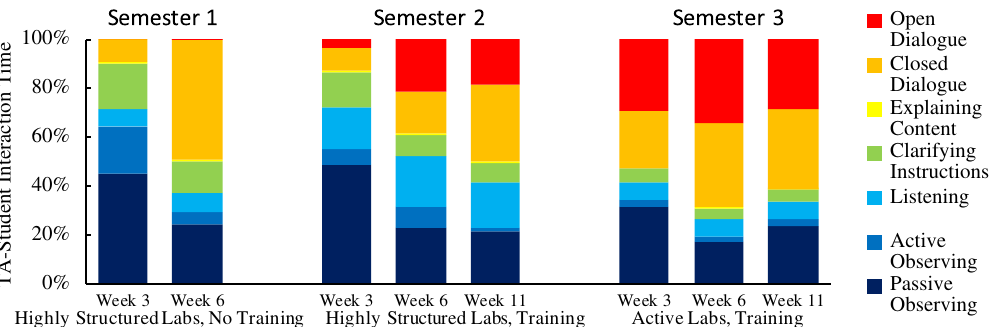
FIG. 4. Comparison of TA-student interactions across three semesters, averaged over all observed TAs. A different set of TAs was observed each semester, and all TAs observed were working their first semester as a lab TA. In the first semester, a highly structured lab curriculum was used with no lab TA professional development. TAs become more comfortable engaging in dialogue with students, but do not practice open dialogue, which would support inquiry-style learning. In the second semester, lab TAs received specialized professional development and demonstrated increasing levels of both open dialogue and listening to students over the semester. In the third semester, an active-engagement curriculum was adopted and the lab TA professional development continued. In this third semester, TAs engaged in open dialogue throughout the